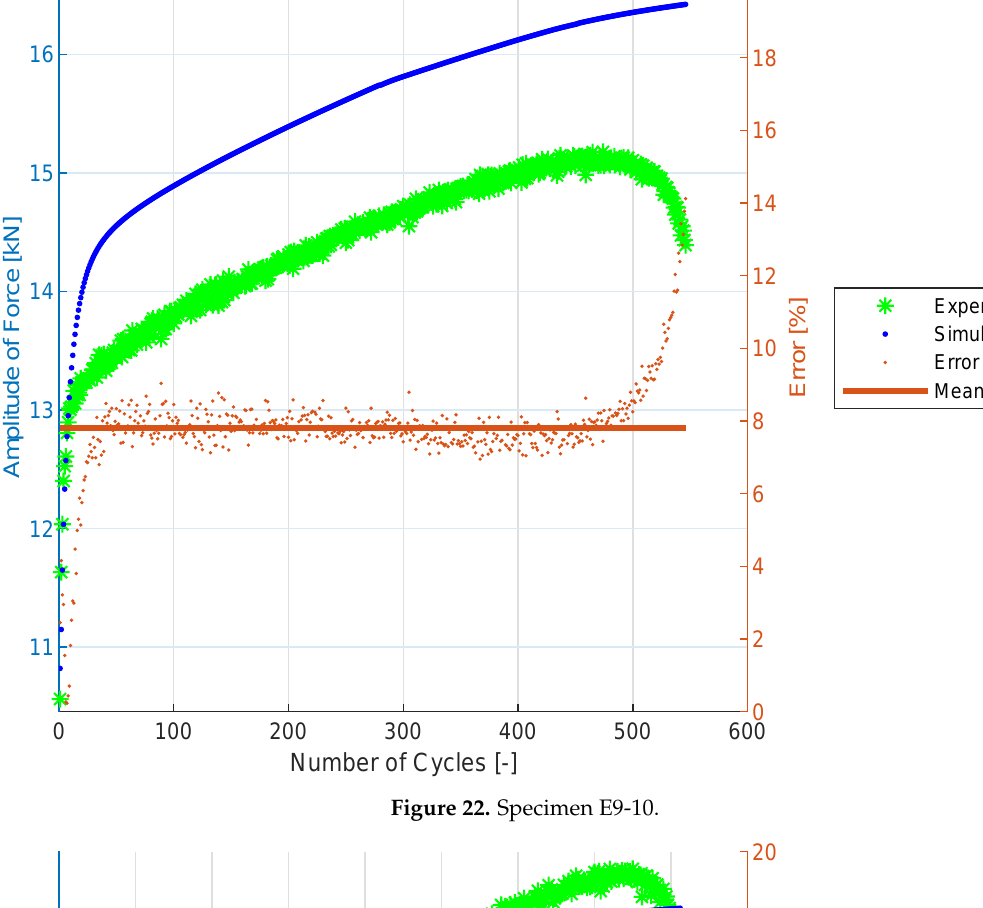
Figure 22. Specimen E9-10.